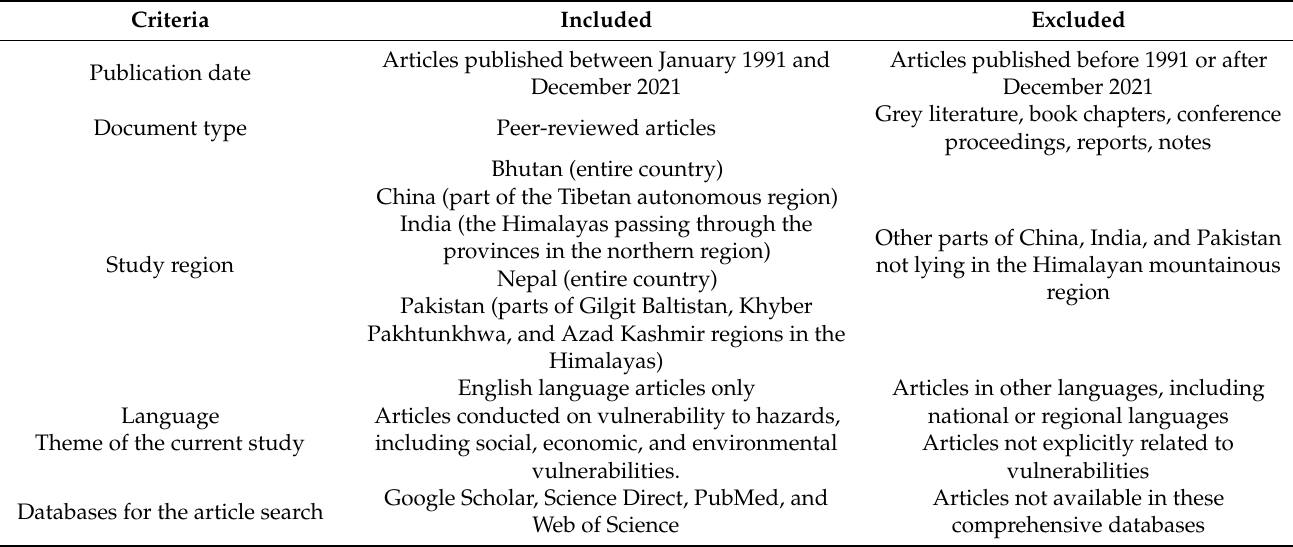
Table 1. The criteria for the inclusion and exclusion of scientific papers in the review